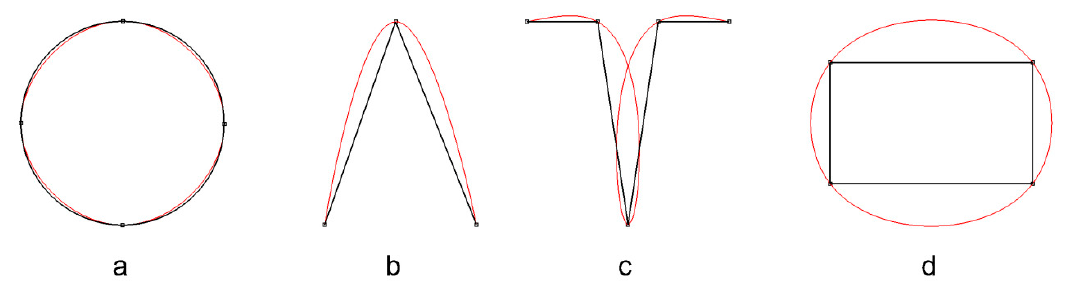
Figure 2. Spline function describing a smooth structure ( a ), with one kink ( b ), and structures with different numbers and locations of kinks ( c , d ).